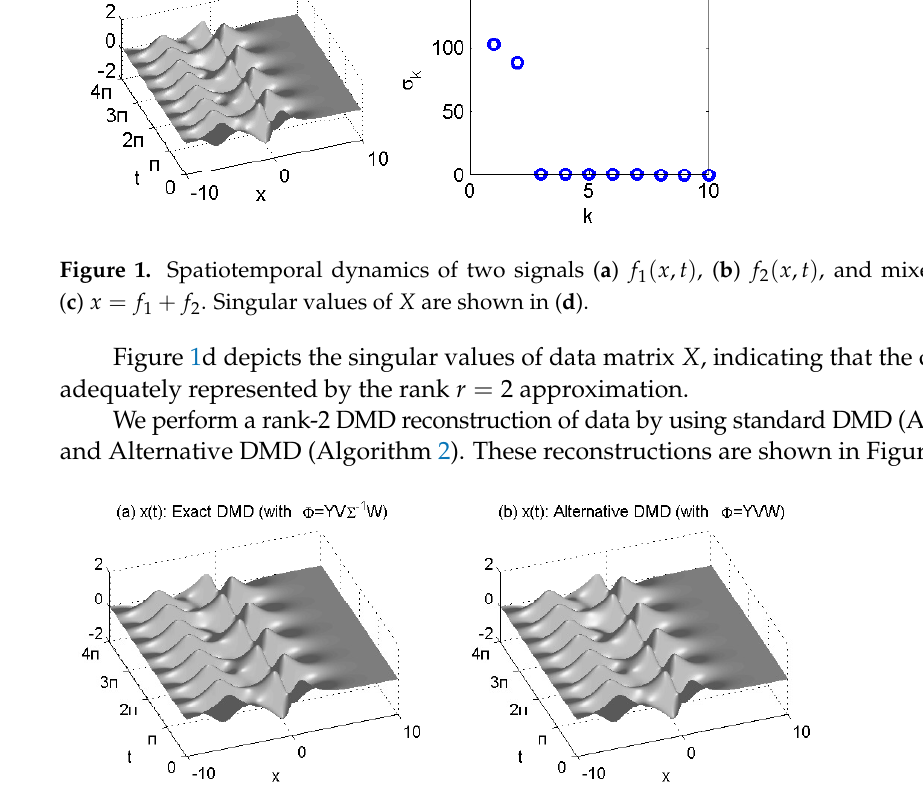
Figure 2. Rank − 2 reconstructions of the signal X by: standard DMD ( a ) and Alternative DMD ( b